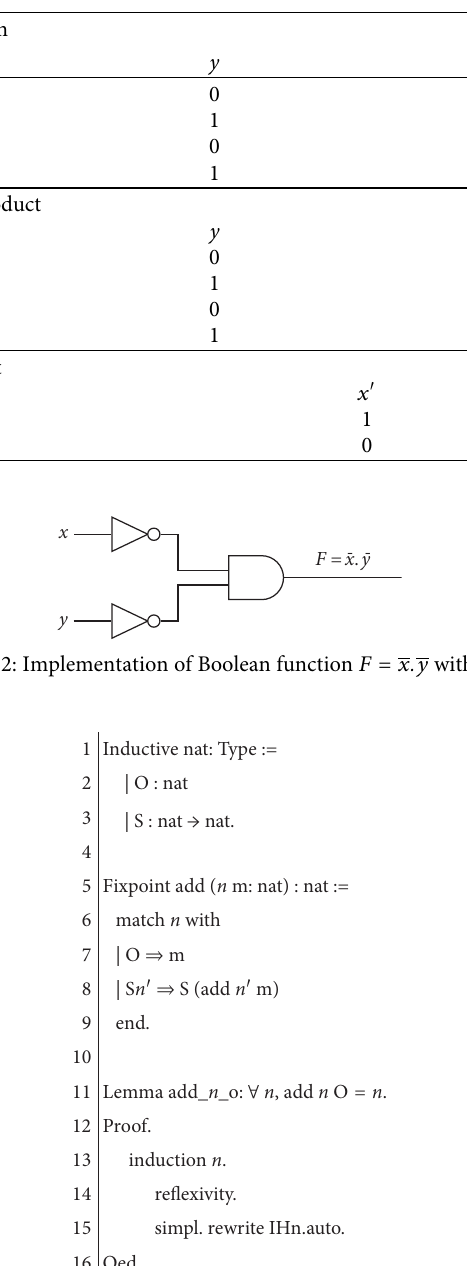
Table 2: Truth tables for sum (a), product (b), and not (c) operations.